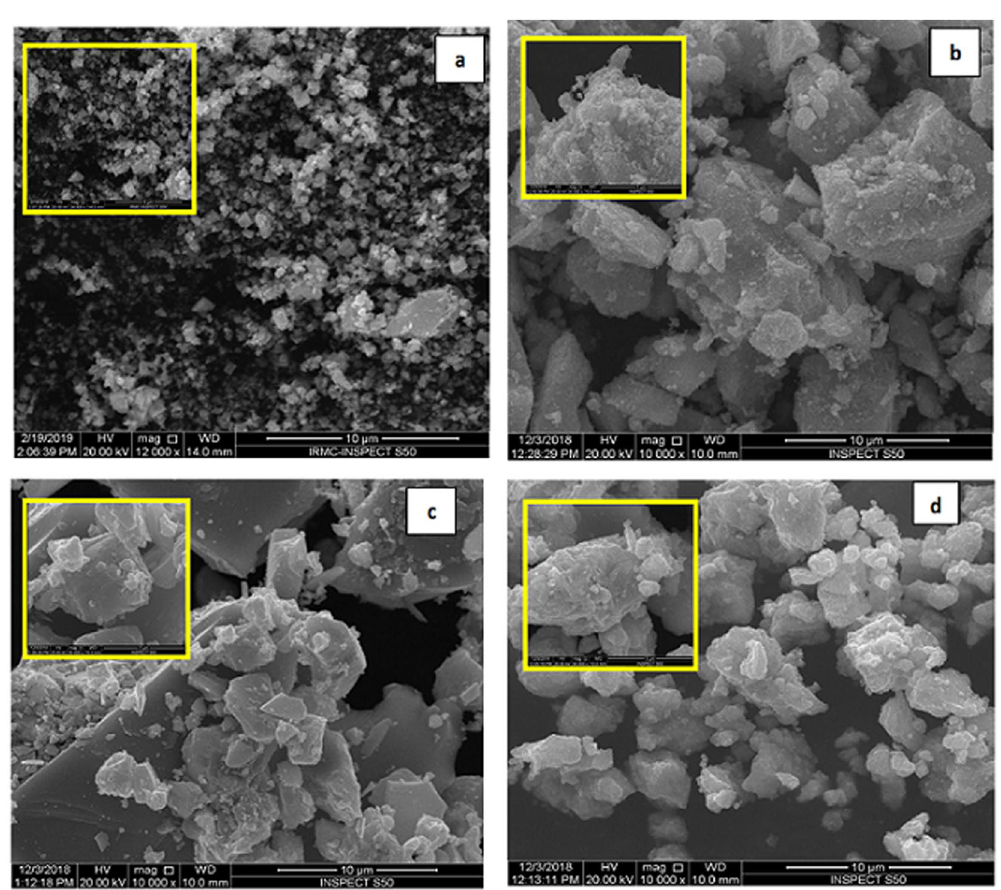
Figure 3. SEM images of ( a ) In 2 O 3 NPs, ( b ) 5%, ( c ) 10%, and ( d ) 15% Sn doped indium oxide